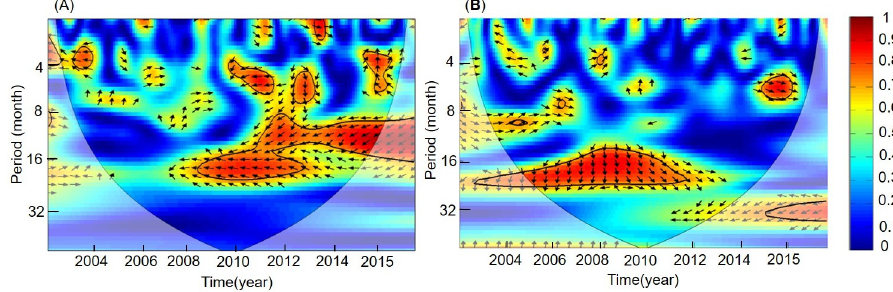
Fig 7. Wavelet coherency analysis of variables in the Yellow Sea, China. (A) Wavelet coherency between Chl- a and SST during 2003–2015 in the Yellow Sea. (B) Wavelet coherency between Chl- a and Ni ñ o 3.4 during 2003–2015. (The thick lines show the 95% confidence levels, and the thin lines separate the cones of influence. The color bar indicates the intensity of the correlation, and the direction of arrows show the correlation type with the right-pointing arrows being positive and left pointing arrows being